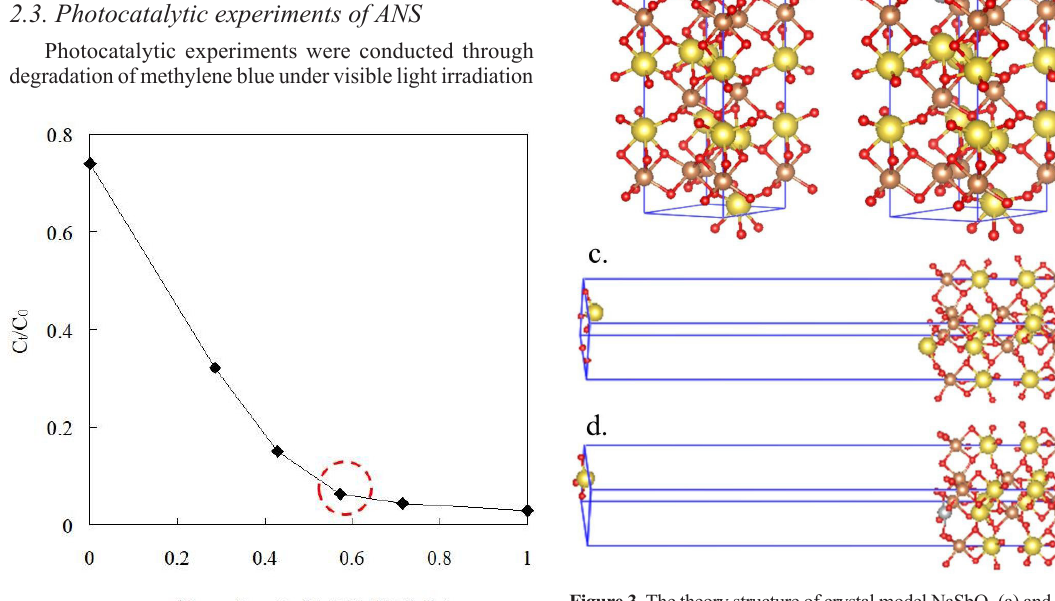
Figure 3. The theory structure of crystal model NaSbO Catalyst (b), and the theory structure of surface model (for work function calculation) NaSbO (c) and ANS catalyst (d) (yellow ball is Na atom, /NaSbO ) in synthesis 3 3 3 coffee ball is Sb atom, red ball is O atom, grey ball is Ag